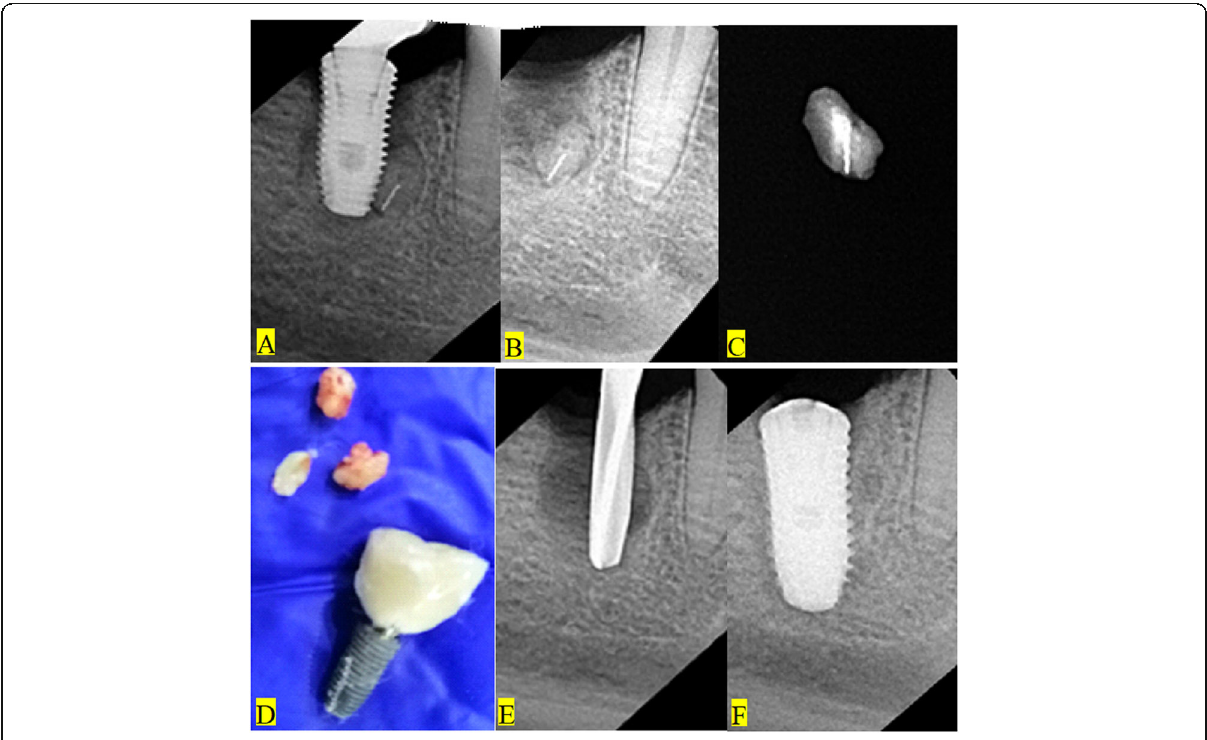
Fig. 4 Implant failure due to the presence of a radiopacity of endodontically treated remaining root with a fractured endodontic file. a The radiopacity deep in close proximity to the mandibular implant. b The radiopacity after removal of the implant with evidence of tissue reaction. c Radiographic examination of the removed remaining root with endodontic filling remnants and the broken file. d A photograph of the removed implant and the remaining root fragments. e Preparation of the site for a longer and wider new implant fixture. f The new fixture in